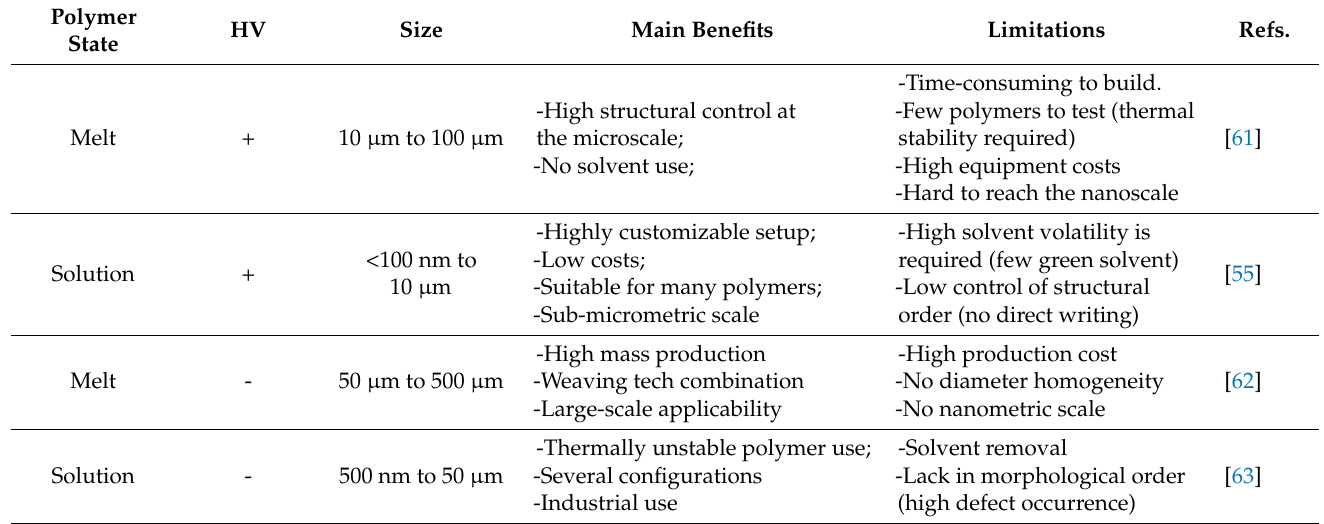
Table 1. Comparative analysis of fiber manufacturing via melt and solution